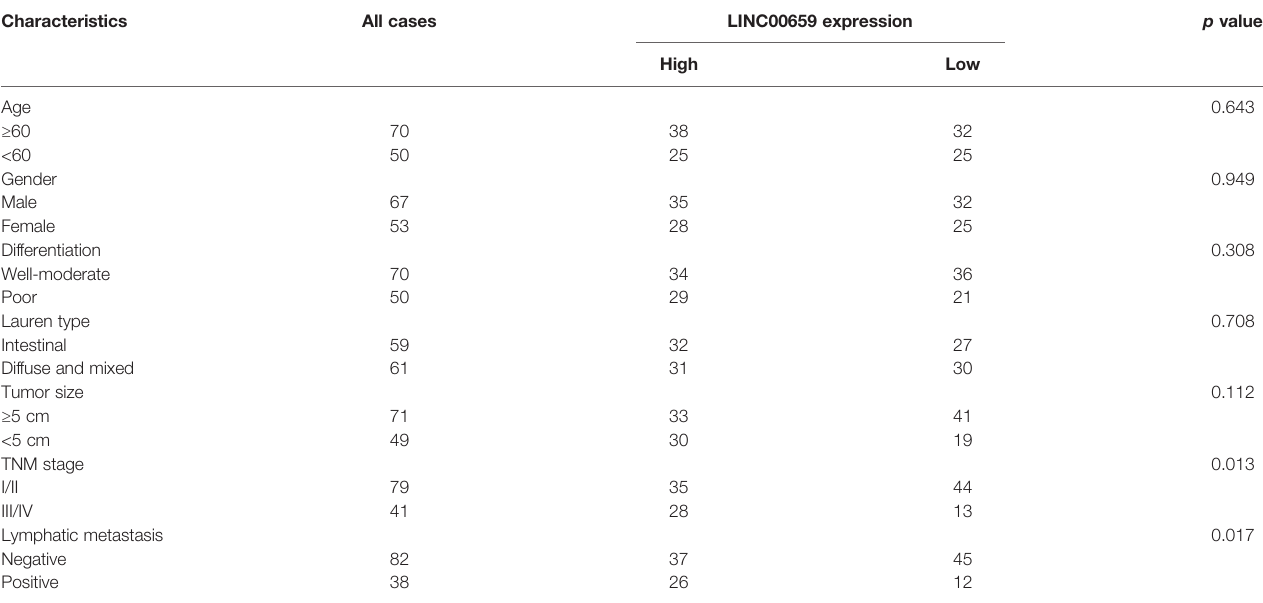
TABLE 2 | Correlation of clinicopathological features of GC with LINC00659 expression levels. Characteristics